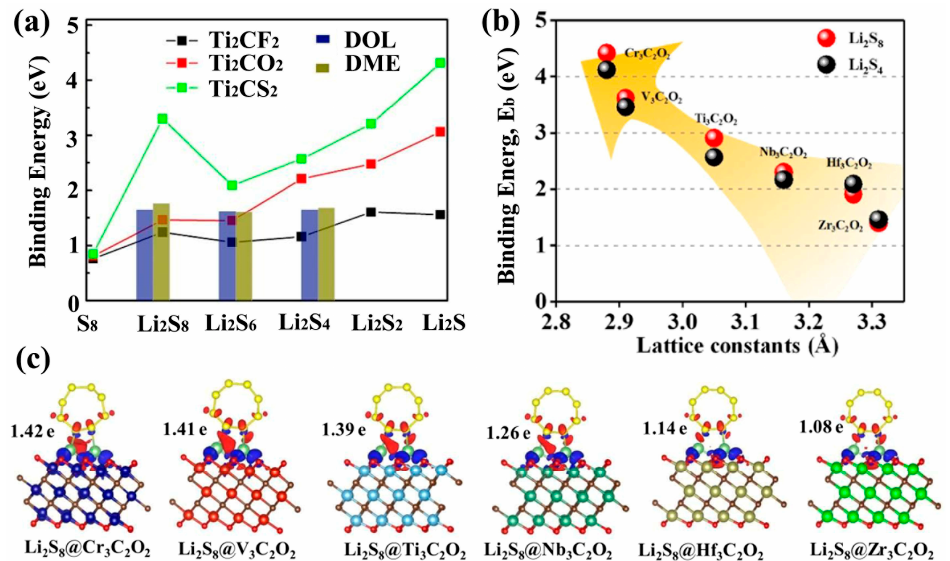
Figure 3. ( a ) Comparison of binding energies between LiPSs and Ti 2 CT x with different surface terminations [85]. Copyright 2018, Elsevier. The binding energies ( b ) and differential charge density ( c ) for Li 2 S 8 and Li 2 S 4 as a function of lattice constants of M 3 C 2 O 2 (M = Zr, V, Ti, Nb, Hf and Cr) MXenes [87]. Copyright 2019, RSC Pub.